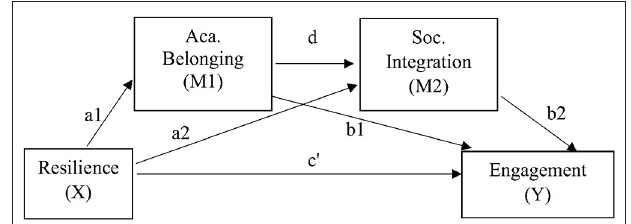
FIGURE 1 | Explanatory serial mediation model with hypothesized direct pathway, independent mediation pathways, and serial mediation pathway between engagement, resilience, academic belonging, and social integration. Aca, academic; Soc, social.